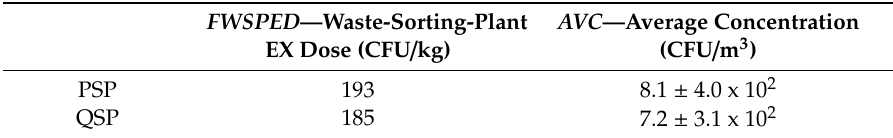
Table 3. Calculated fungal waste-sorting plant exposure dose ( FWSPED ) inhaled by WSP sta ff and average concentration (AVC) of fungal aerosol ±